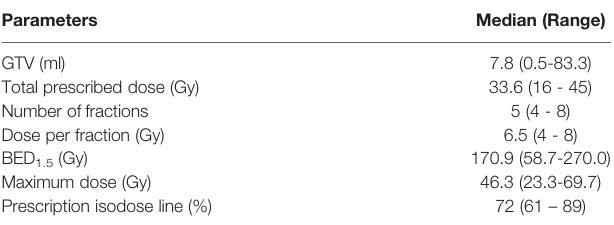
TABLE 2 | Treatment parameters for SBRT.